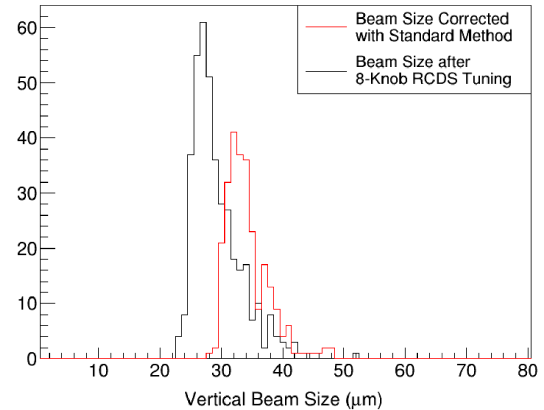
FIG. 6. Histogram of hundreds of experimental vertical beam size measurements both after applying just the standard Leven- berg-Marquardt minimization of dispersion and coupling and after additional tuning with the RCDS algorithm using the best 8 eigenparameters. A modest but unambiguous improvement is observed. Note also the high-side tails of the measurement